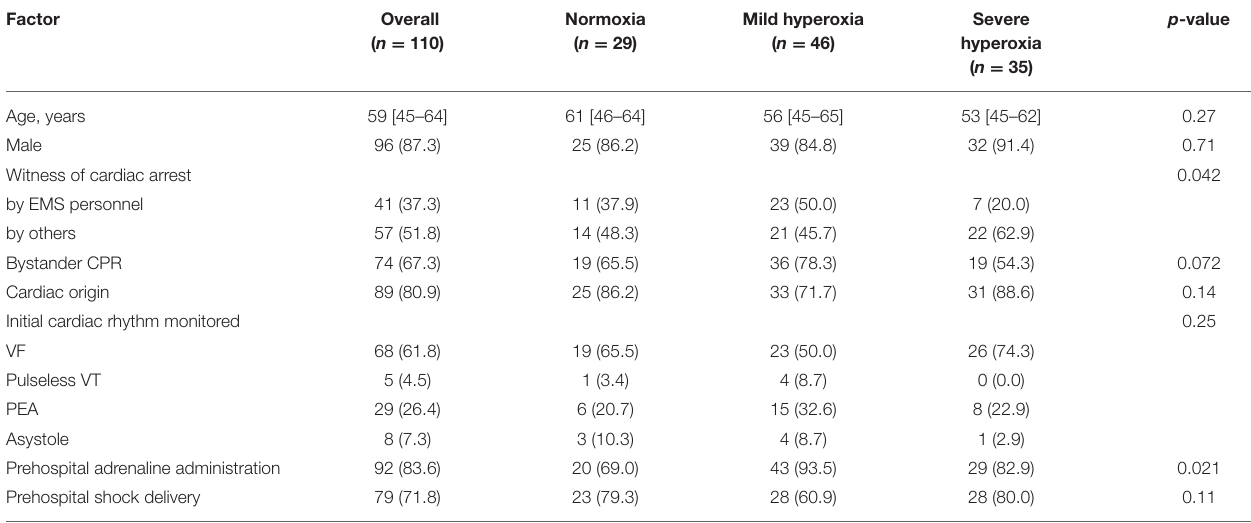
TABLE 1 | Demographic and pre-hospital characteristics of the study